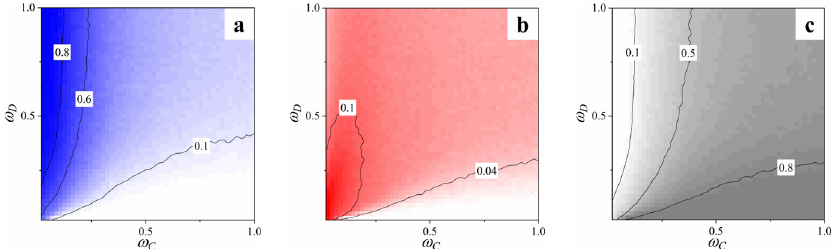
Figure 4. Fractions of ( a ) cooperators (blue), ( b ) defectors (red), and ( c ) loners (gray) as functions of cooperators’ and defectors’ weights ( ω C and ω D ) in a single game. The other parameters are r = 3.5, α = 1, γ + = γ − = 0.5, λ = 2, M = 100 .